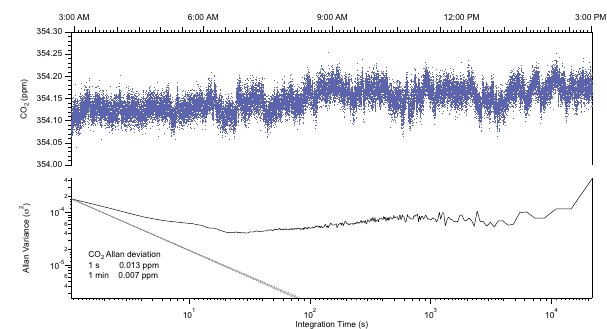
Fig. 5. Short-term stability test of ABC. A secondary sealed quartz cell was measured using the null method at 1Hz for 3h, under rapid room temperature change of 5K magnitude. Bottom panel: room temperature (scale on the left) and optics temperature (a much smaller scale on the right); middle panel: CO 2 absorption line peak position, indicating the laser frequency drift as a result of the tem- perature variation; top panel: measured equivalent CO 2 mixing ratio from the secondary sealed quartz cell.